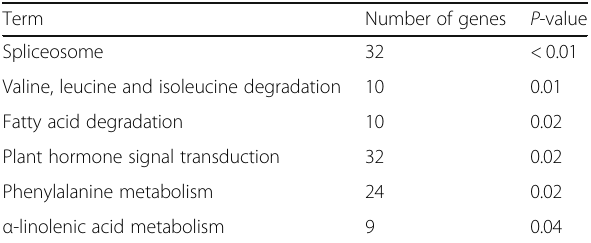
Table 4 KEGG analysis of the response of Rhizoglomus intraradices -inoculated wild rice plants to infection by Magnaporthe oryzae in the ‘ Wp+R vs. Wp ’ comparison. Wp +